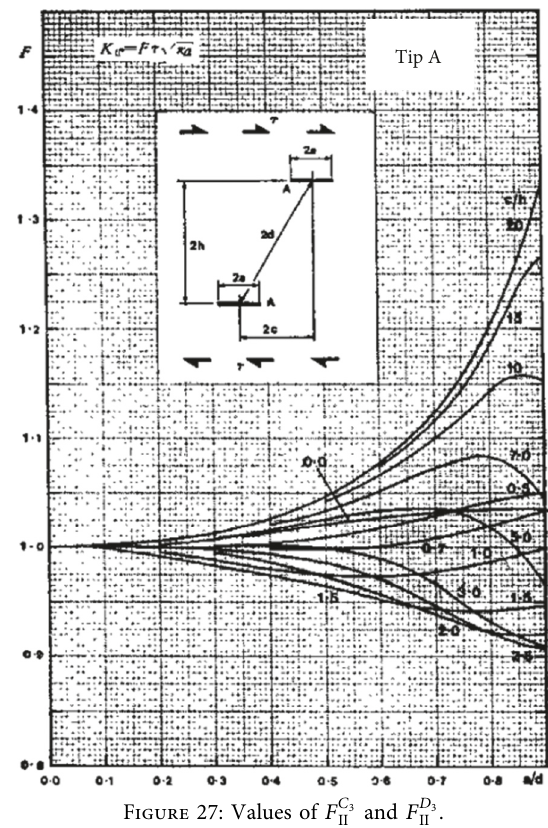
and F D 3 ΙΙ ΙΙ